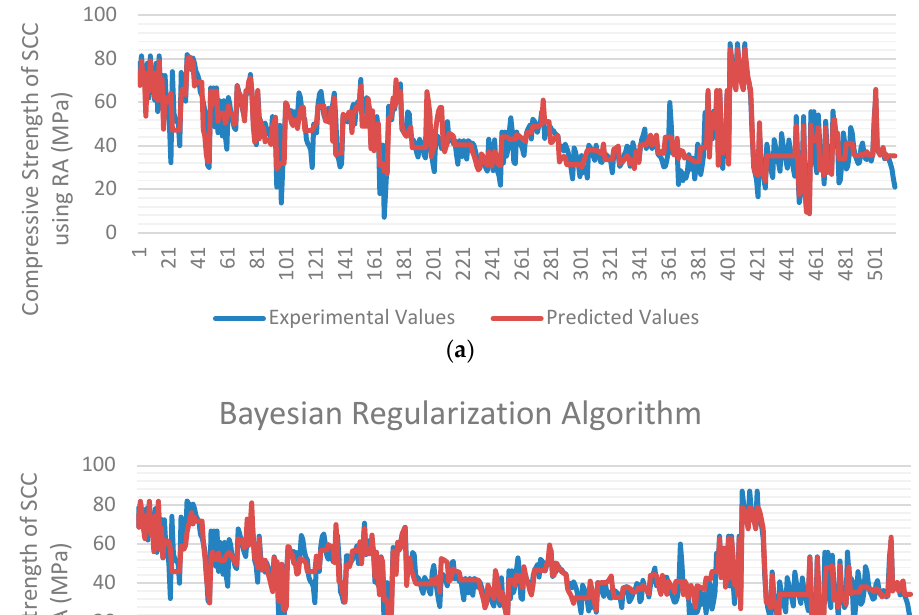
strength using recycled aggregates. The data set of 515 samples is shown on the x -axis.